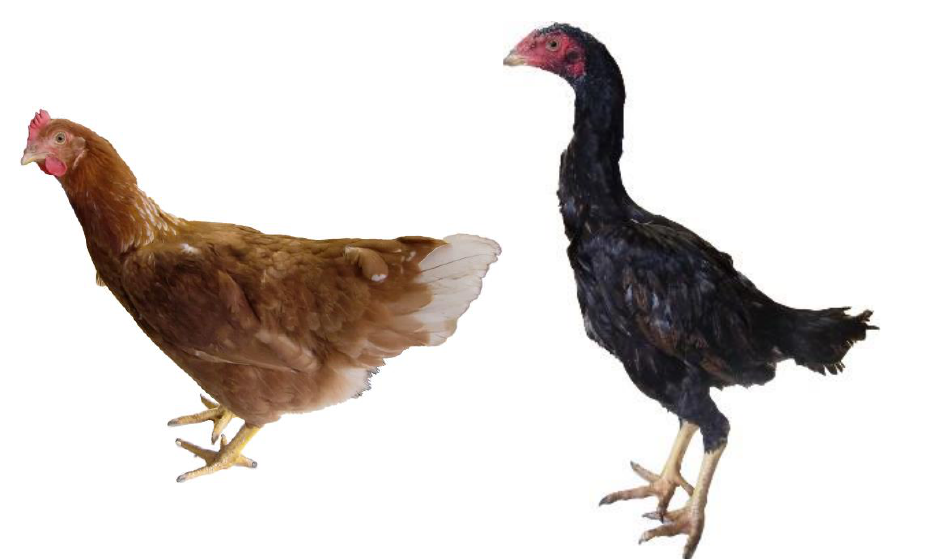
Figure 1. Characteristics of female Shaver Brown and Shamo chickens. Left: Shaver Brown. Right: Shamo [1]. Table 1. Accession numbers of nine adrenergic receptor (ADR) genes in Shaver Brown and Shamo chickens. Sample